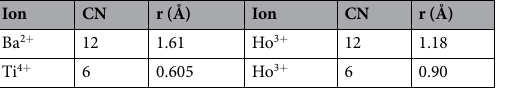
Table 1. Ionic radii as a function of coordinate number (CN) 16